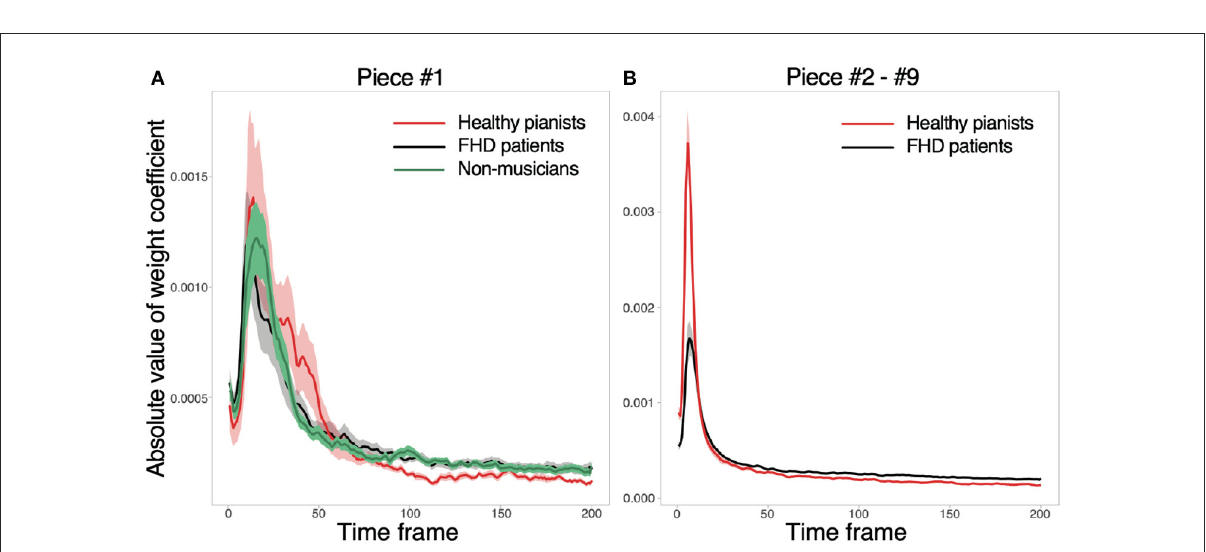
FIGURE3 Absolute values of w in each time frame. (A) The absolute values for piece #1. Red, black, and gray solid lines indicate averaged absolute values of w across healthy pianists, patients with FHD, and non-musicians, respectively. Shaded areas denote the standard error of the mean. (B) The absolute values of w for pieces #2-#9.